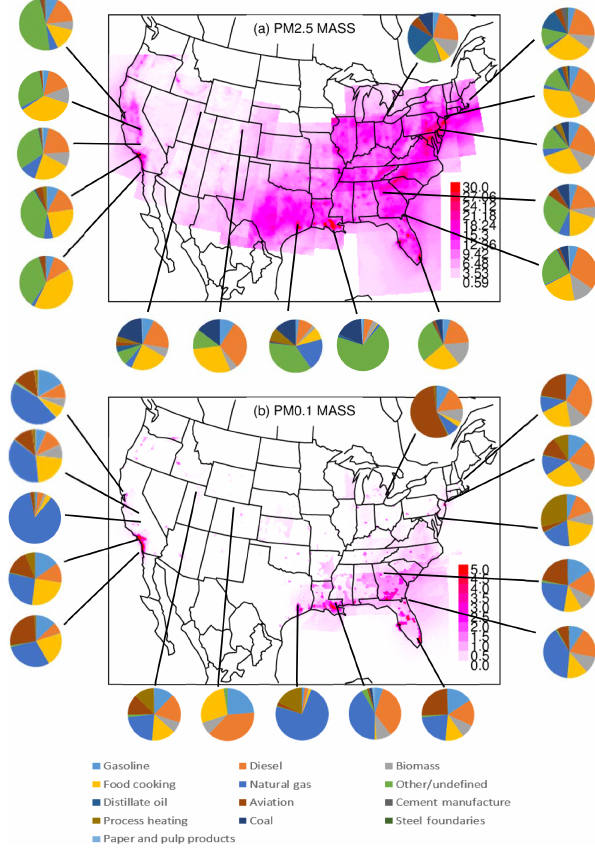
Figure 6. (a) PM 2 . 5 and (b) PM 0 . 1 24h average mass (µgm − 3 ) during summer air pollution event. Scale drawn to highlight all areas of the US. Actual maxima: (a) 94 . 25µgm − 3 ; (b) 9 . 43µgm − 3